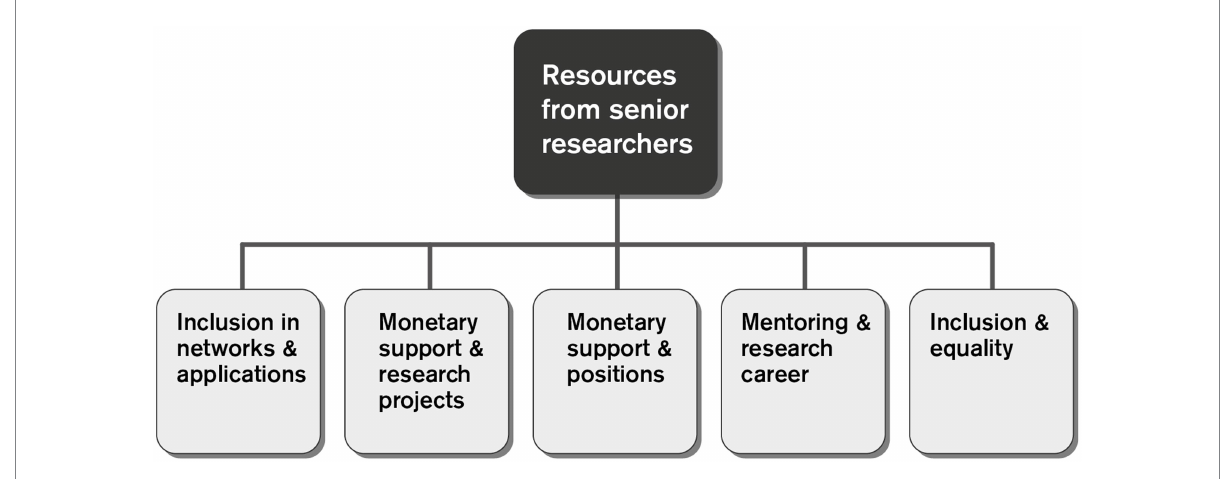
FIGURE 3 Sub-themes that emerged from the focus group discussions of the WECRs’ present situation regarding support, resources, and